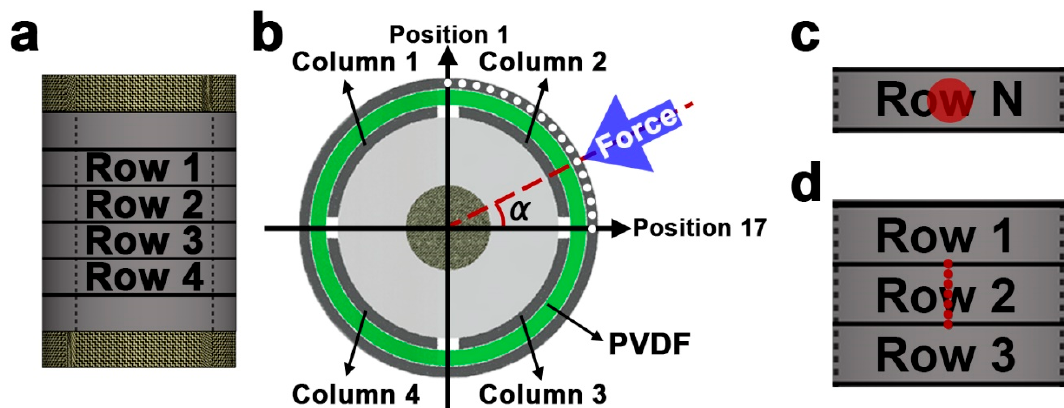
Figure 3. Schematic of the sensor configuration. ( a ) Four row sensors and ( b ) four column sensors with sensor numbers (white circles in column 2 represent the 17 equidistant test points.). The position of the force investigated in the simulation for ( c ) when a force is applied along the lateral midline of each row and ( d ) when a force is applied between the two rows (red circles represent the test points).